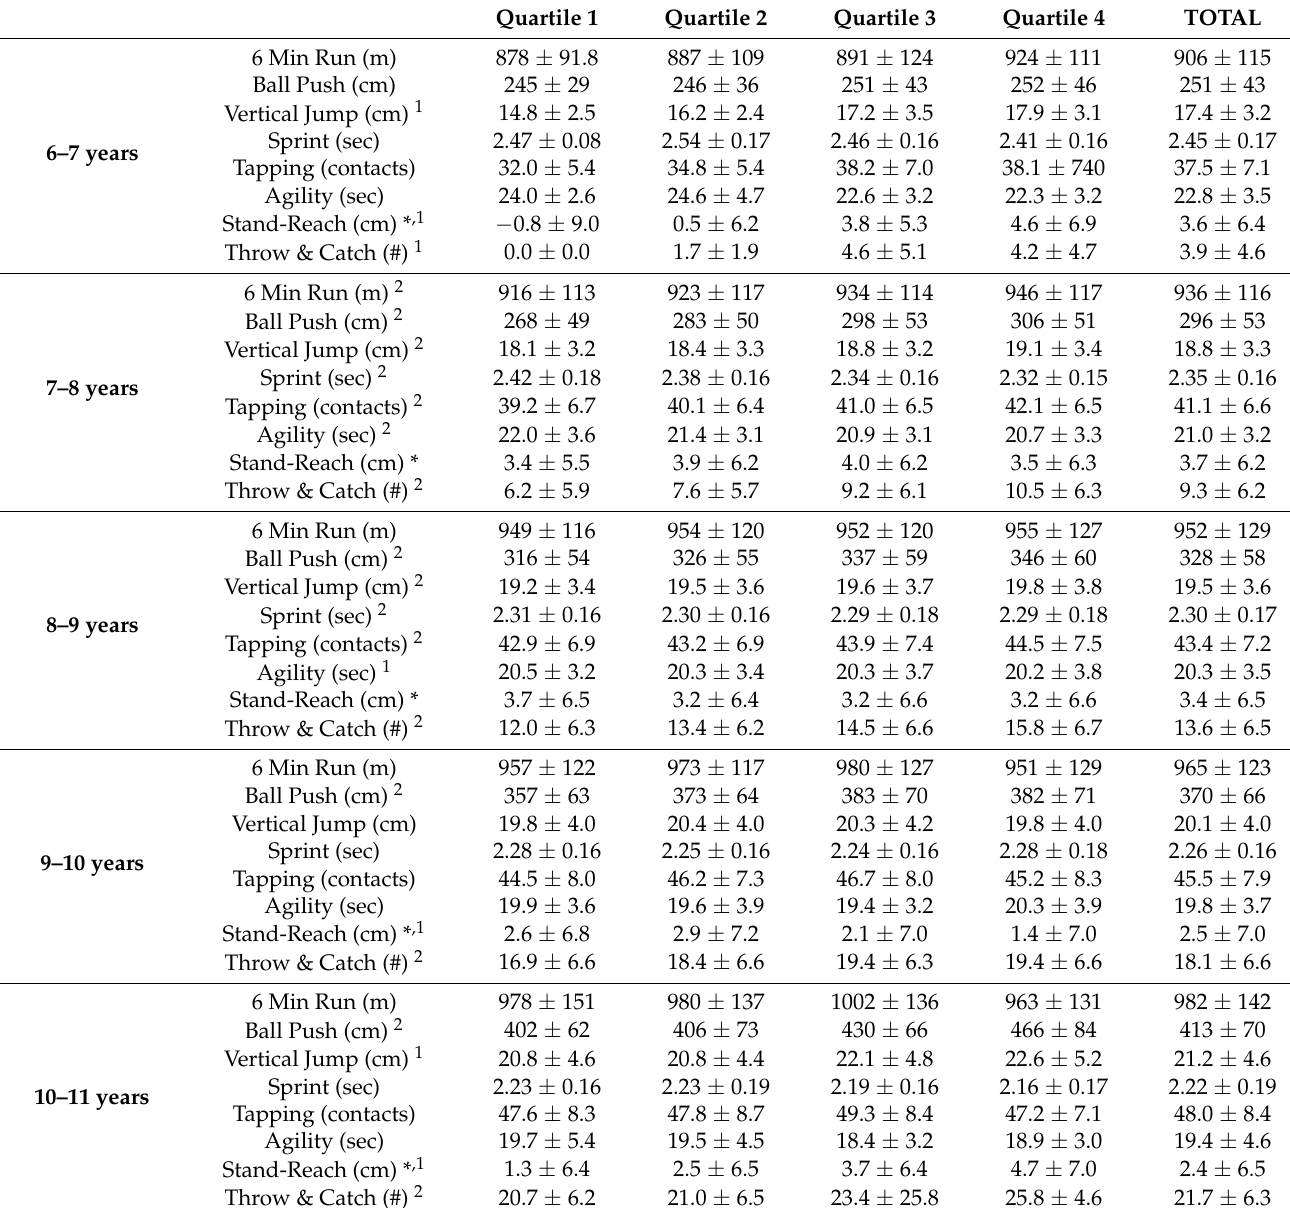
Table 4. Physical fitness by age-group and age-specific quartile in